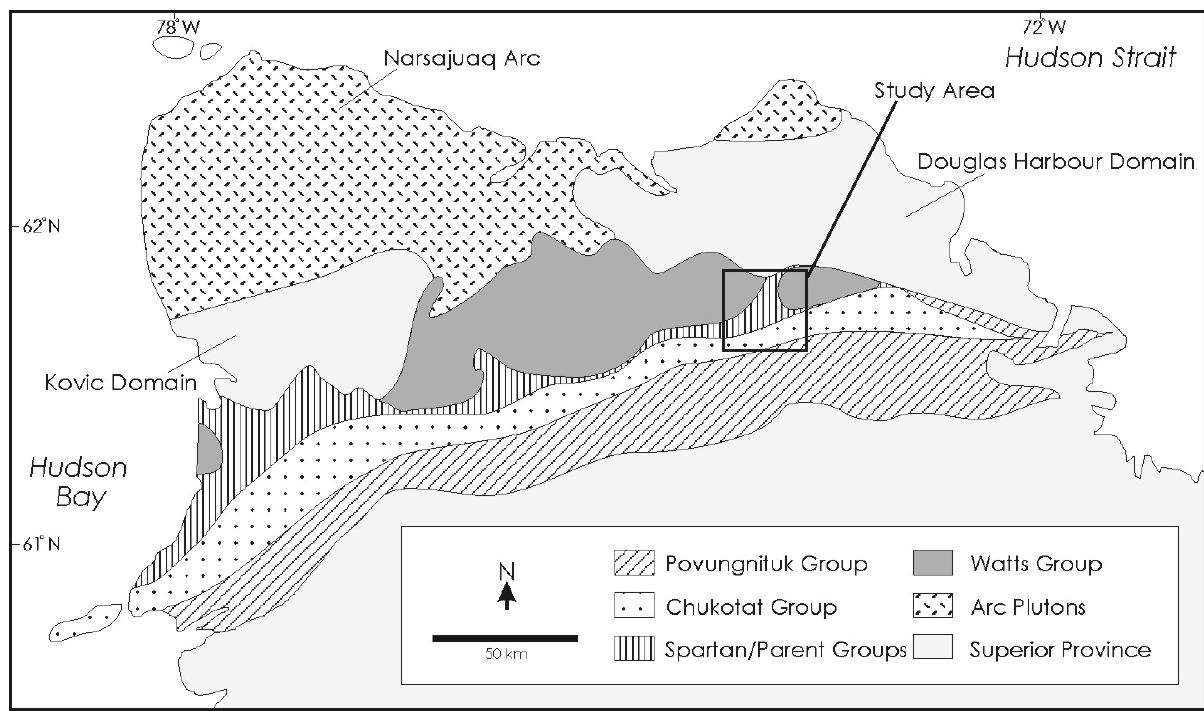
Figure 1. Simplified geological map of the Cape Smith Belt, northern Quebec, Canada (after [34,35]). The location of the study area is